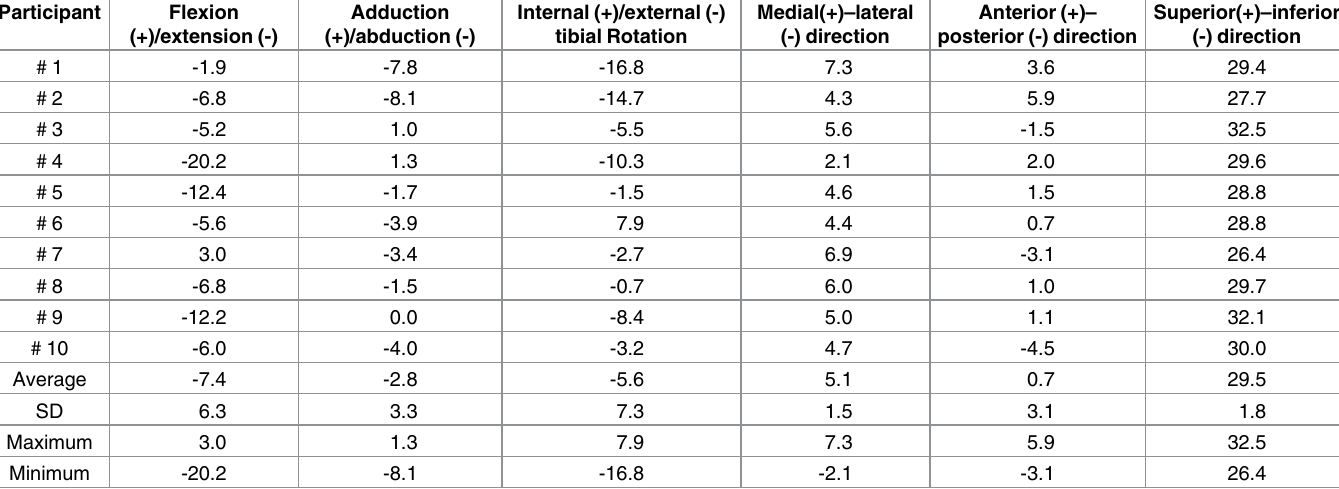
Table 2. Standing posture of the knee joint in 6 degrees of freedom.